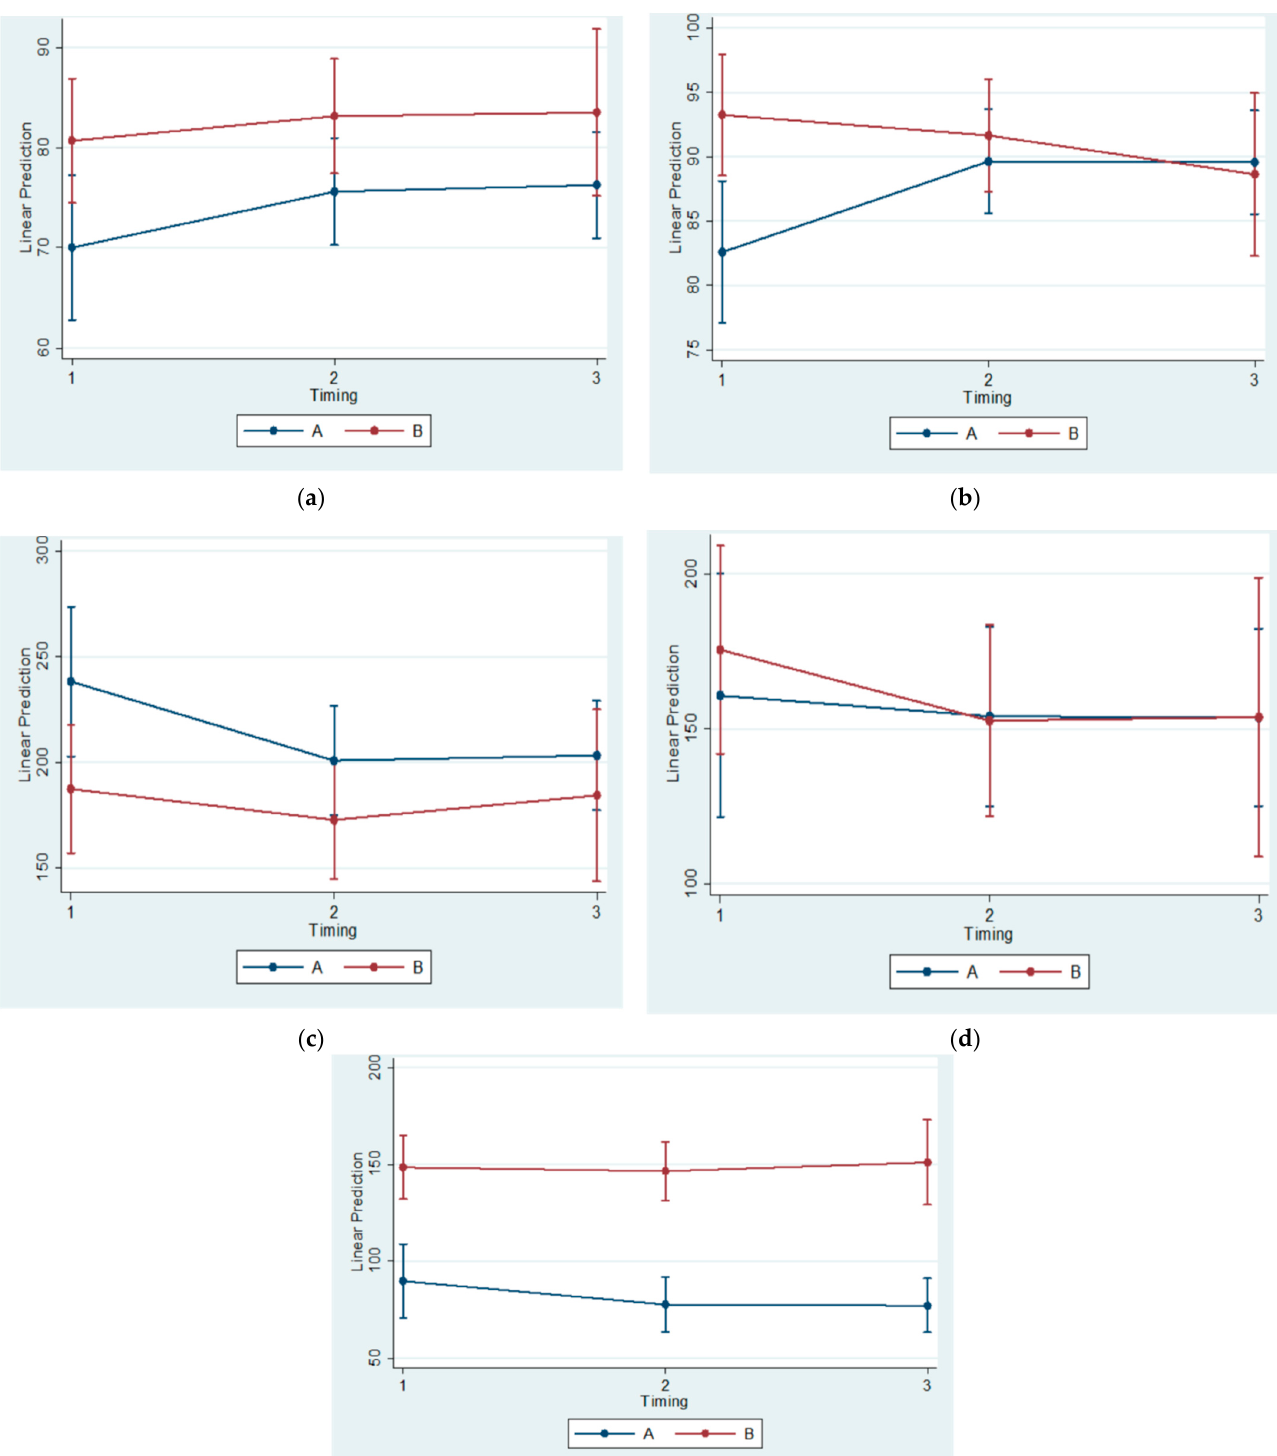
Figure 6. Estimated mean and 95% confidence interval per group and timing in Anterior Ratio Bone Surface/Total Surface ( a ), Posterior Ratio Bone Surface/Total Surface ( b ), Anterior Condylar Cartilage Thickness ( c ), Middle Condylar Cartilage Thickness ( d ), and Posterior Condylar Cartilage Thickness ( e ).